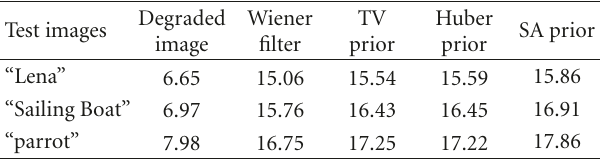
Table 3: Signal-to-noise ratio (SNR) of the observed degraded images and the restored images.